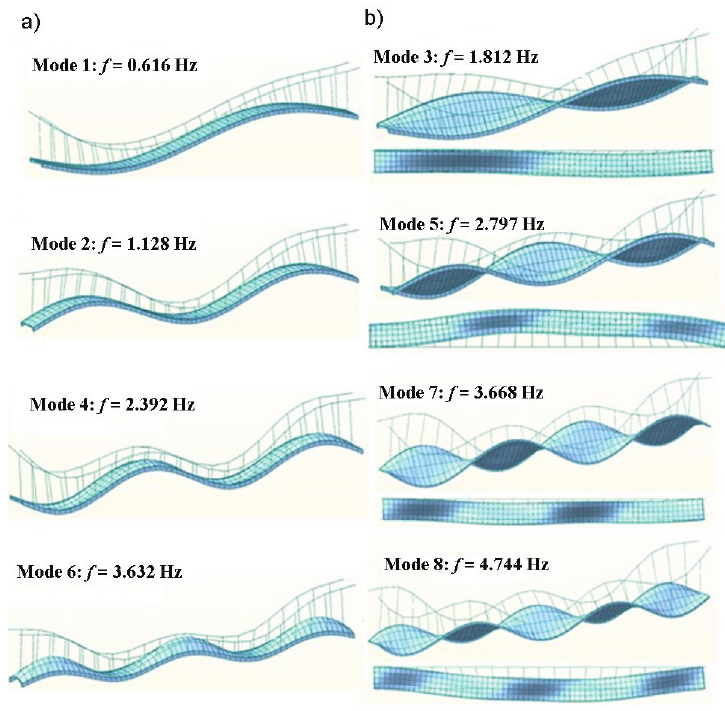
Fig. 6. Mode shapes of the first four vertical (a) and four coupled torsional (b) modes of the model for the